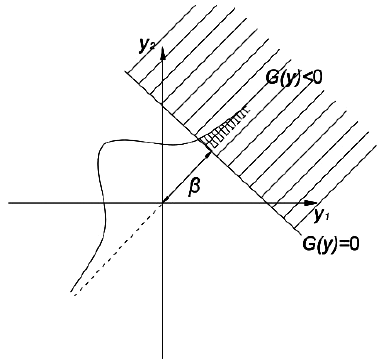
Fig. 1. Graphical representation of β geometrical meaning in two-dimensional case